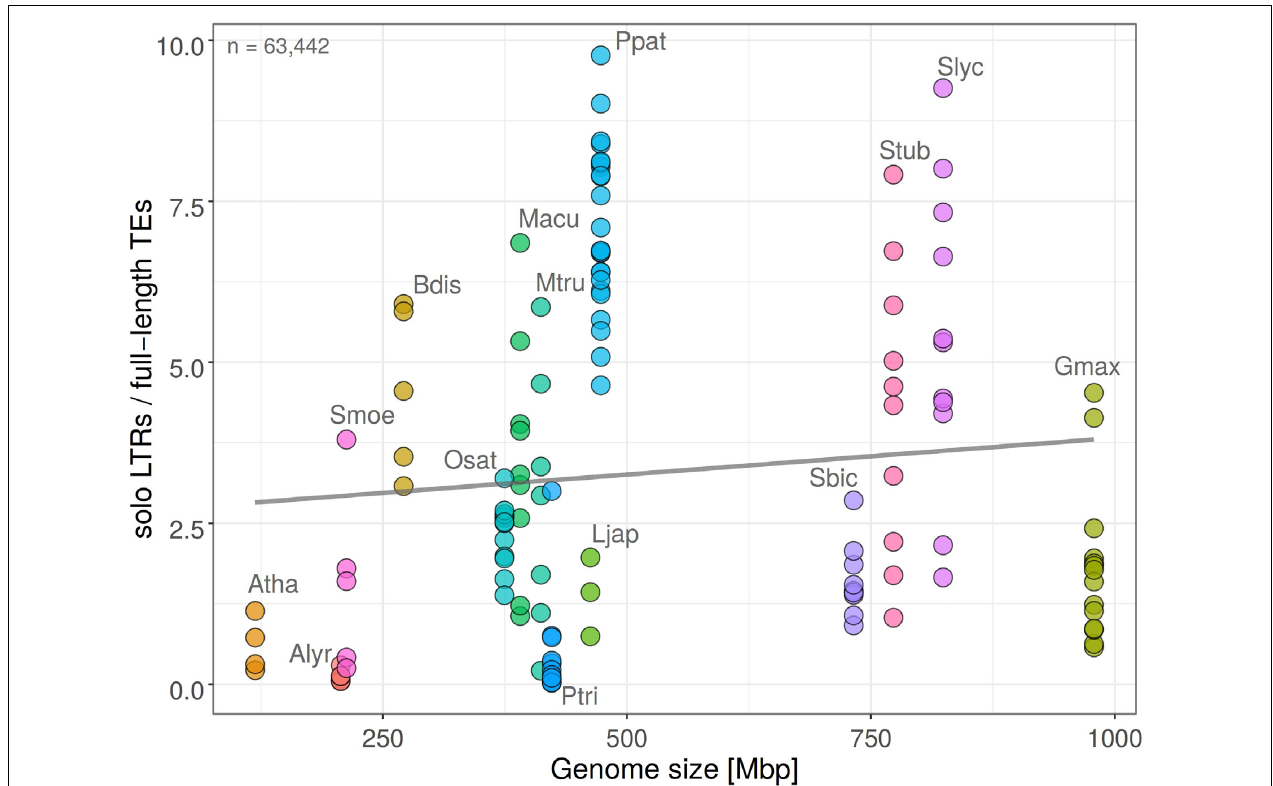
FIGURE 3 | Ratio of solo LTR to full-length retrotransposons (solo LTR/FL) plotted against genome size in fifteen plant species. Each filled circle corresponds to one chromosome, plant species are labeled by different colors ( y = 2.69 + 0.00114 x ; R 2 = 0.011; Pearson’s r = 0.1038 with p -value = 0.2363). Total count of solo LTRs is indicated. Higher solo LTR/FL ratio is observed in larger genomes and corresponds to LTR retrotransposon removal by ectopic